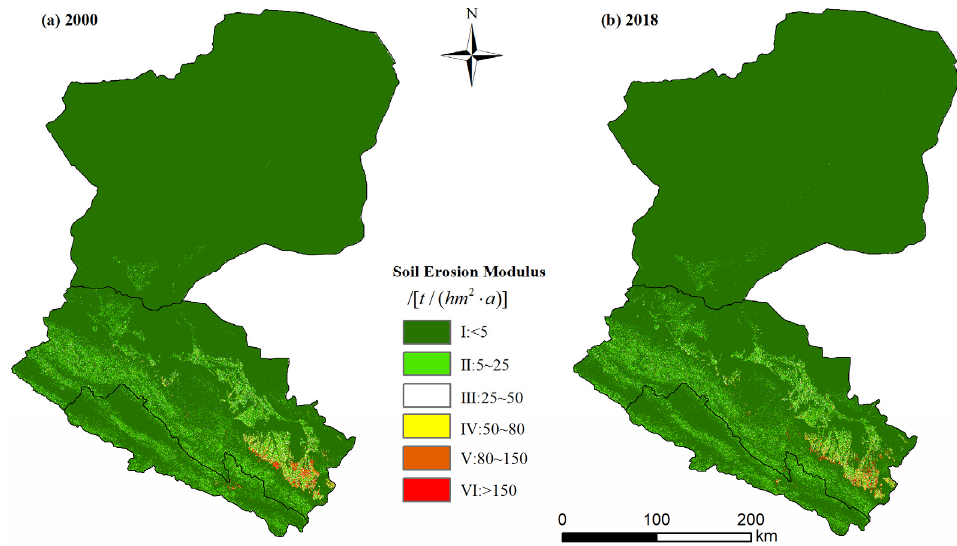
Figure 7. Spatial distribution and changes in soil erosion from 2000 to 2018 ( a ): soil erosion in 2000; ( b ): soil erosion in 2018;).